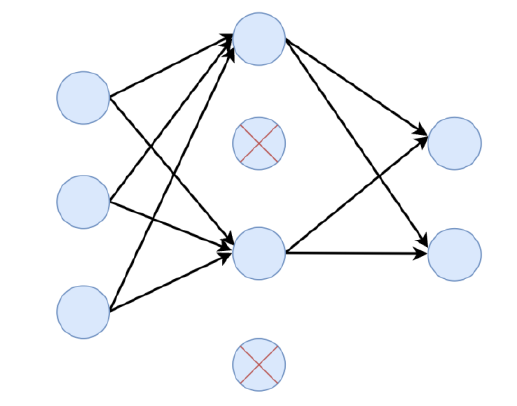
Fig. 6 Dropout in a CNN layer Fully connected layer